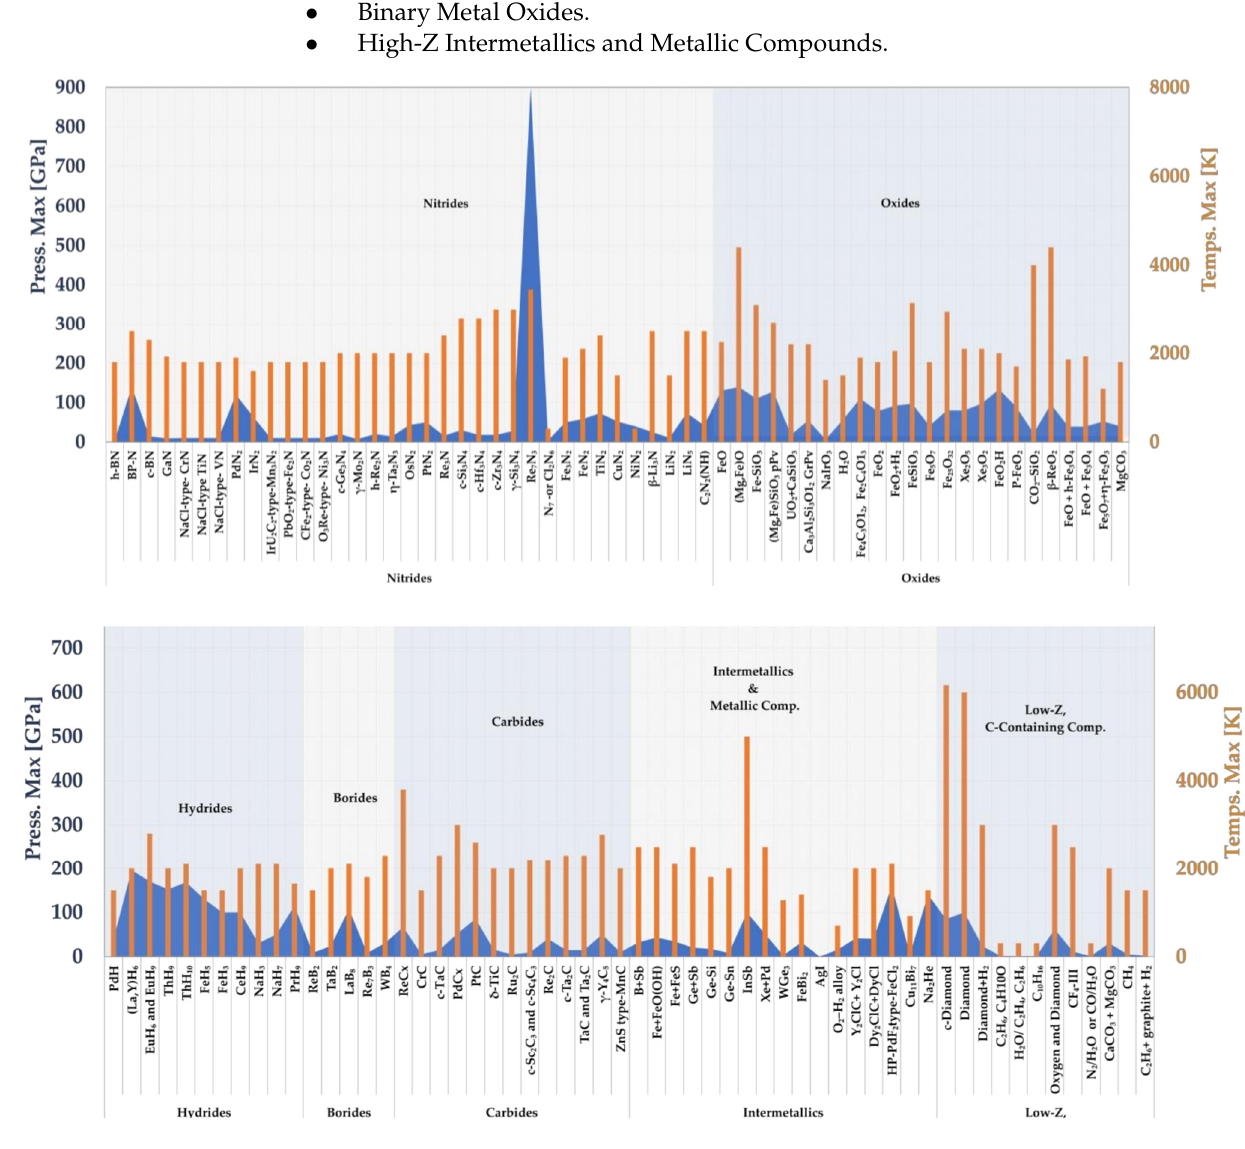
Figure 12. Peak P-T Conditions Realised During LRS-DAC Synthesis of Low-Z, Carbon-Containing Compounds.